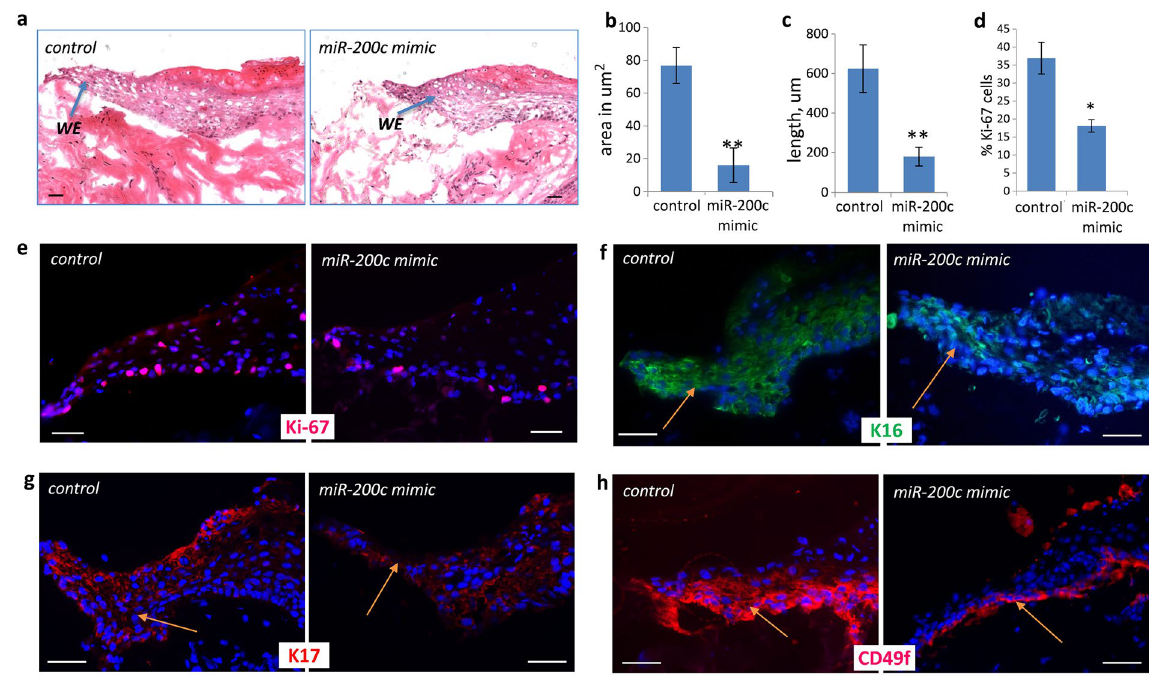
Figure 3. miR-200c delays wound healing in human skin ex vivo . ( a ) Representative images of wound histology of miR-200c mimic and negative control RNA treated skins 5 days post-wounding (H&E staining, WE – wound epithelium, scale bar 50 µ m); ( b ) Significantly reduced area of wound epithelium in miR-200c mimic treated wound on day 5 after wounding versus the control (n = 5; mean ± SE, *** p < 0.0001, Student’s t-test); ( c ) Significantly reduced wound epithelial tongue length in miR-200c mimic treated wounds on day 5 post-wounding (n = 5; mean ± SE, *** p < 0.0001, Student’s t-test); ( d–e) Ki-67 + proliferating keratinocytes seen in the wound epithelial tongue of ex vivo human wounds following 5 days of miR-200c mimic treatment (scale bars 50 μ m); significantly decreased percentage of Ki-67 + proliferating cells in the wound epithelium after 5 days of miR-200c mimic treatment compared to the control (n = 4; mean ± SE; * p < 0.05; Student’s t test). ( f ) Reduced expression of Keratin 16 in miR-200c mimic treated wounds compared to the control (arrows; scale bar 50 µ m); ( g ) Decreased expression of Keratin 17 in miR-200c mimic treated wounds compared to the control (arrows; scale bar 50 µ m); ( h ) The expression of CD49f is suppressed in miR-200c mimic treated wounds compared to the control (arrows; scale bar 50 µ